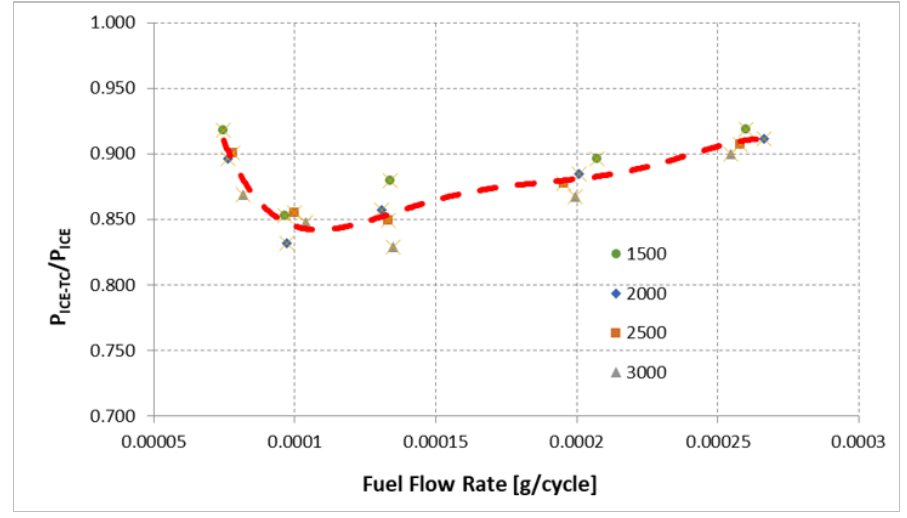
Figure 7. Power unit efficiency PU  compared to ICE efficiency without turbocompound ICE  , as a function of fuel flow rate (g/cycle). Marks correspond to ICE speed (rpm).